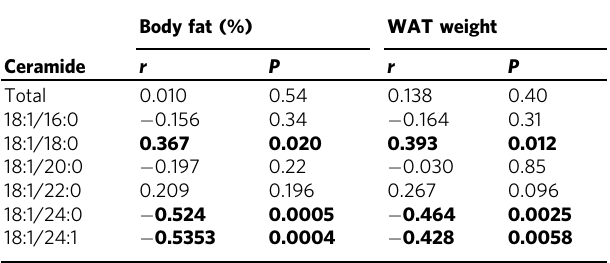
confounding effect of P053 on muscle